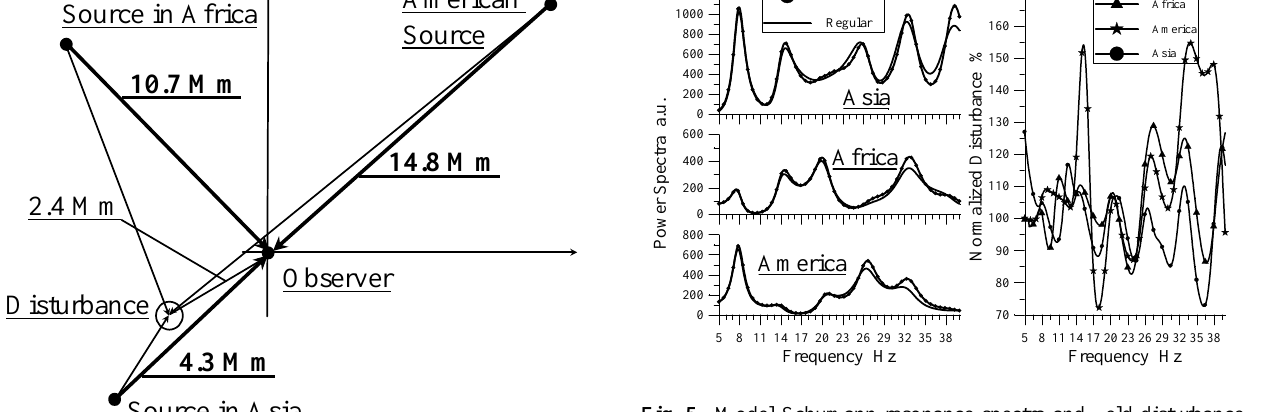
Fig. 5. Model Schumann resonance spectra and field disturbance when regular and disturbed Earth – ionosphere cavity are excited by a point lightning source in Asia (10 (cid:176) N, 105 (cid:176) E), Africa (0 (cid:176) N, 25 (cid:176) E), or America (10 (cid:176) N, 60 (cid:176) W).